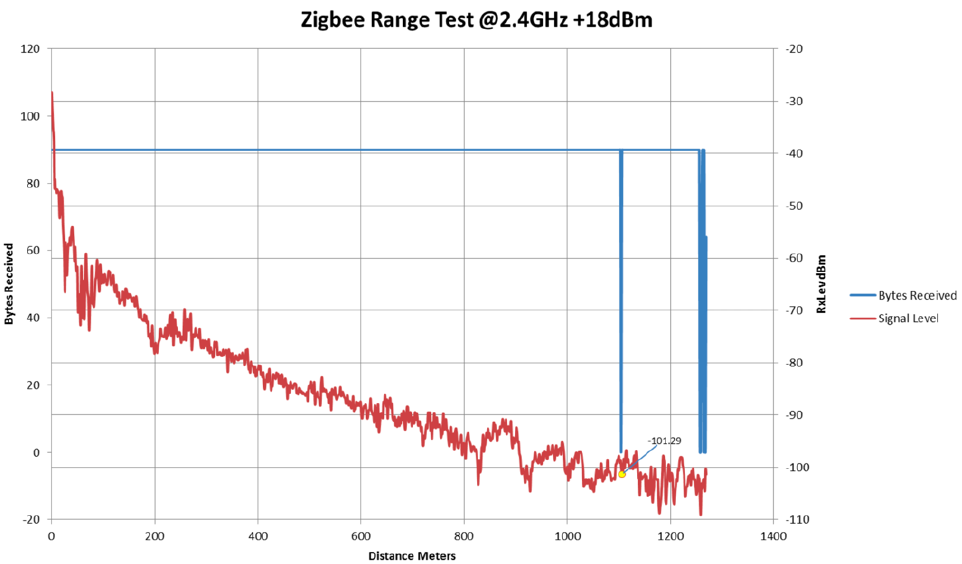
Figure 7. Line-of-sight test at 2.44 GHz ZigBee radio.